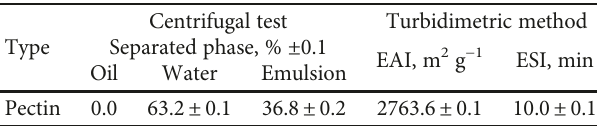
Figure 5: Foaming stability of di ff erent pectin concentration isolated from in vitro cultures of Fumaria o ffi cinalis . Table 5: Stability of emulsions of pectin isolated from in vitro cultures of Fumaria o ffi cinalis